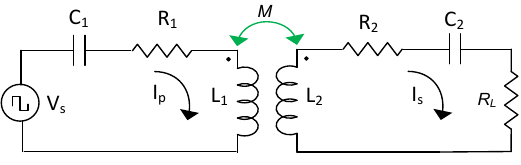
Figure 1. Circuit model for a WPT system with an SS compensation